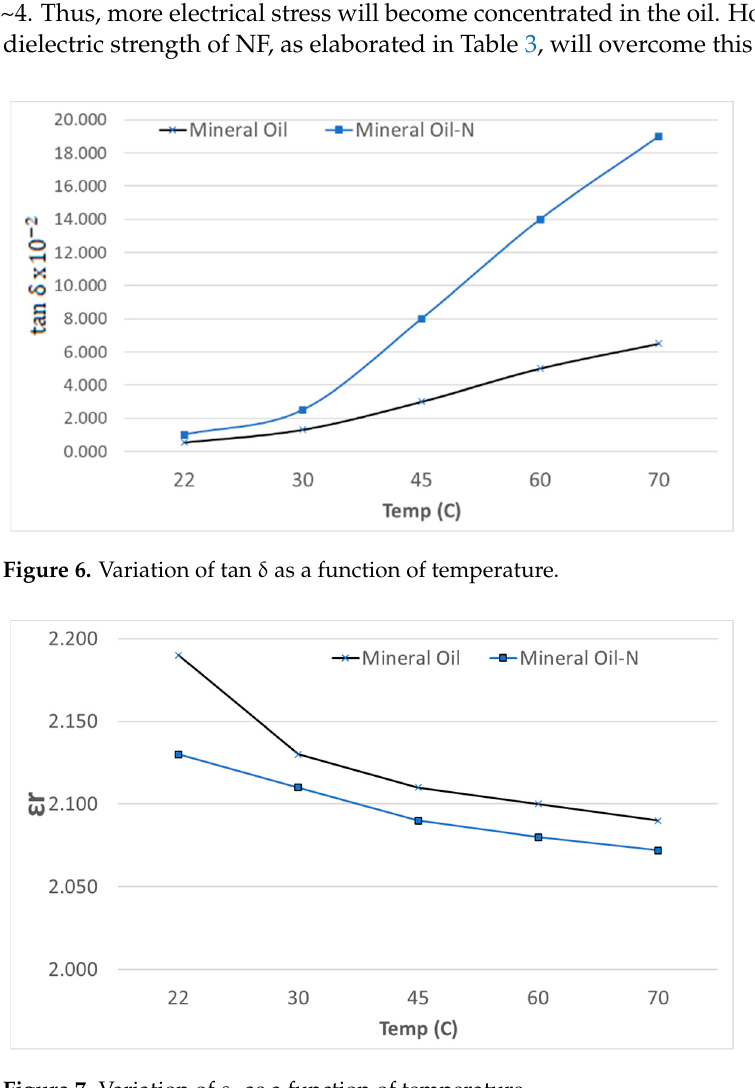
Table 3. Breakdown voltage ( 𝑘𝑉 (cid:3045)(cid:3040)(cid:3046) ) of oil samples as a function of %P.